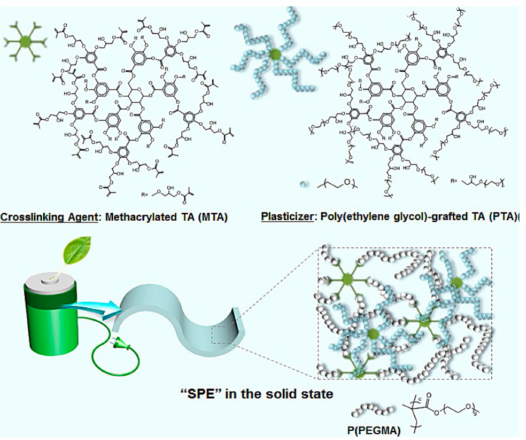
Figure 2. Conceptual illustration of solid polymer electrolytes comprising a crosslinking agent and plasticizer based on functionalized tannic acid